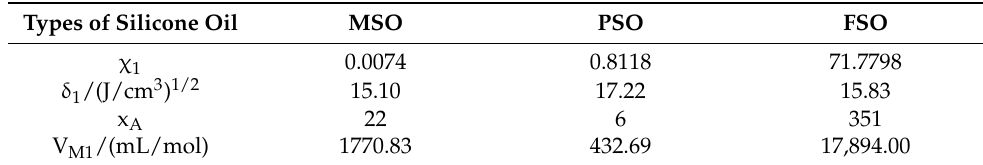
Table 1. The thermodynamic parameters of silicone oil/PDMS.